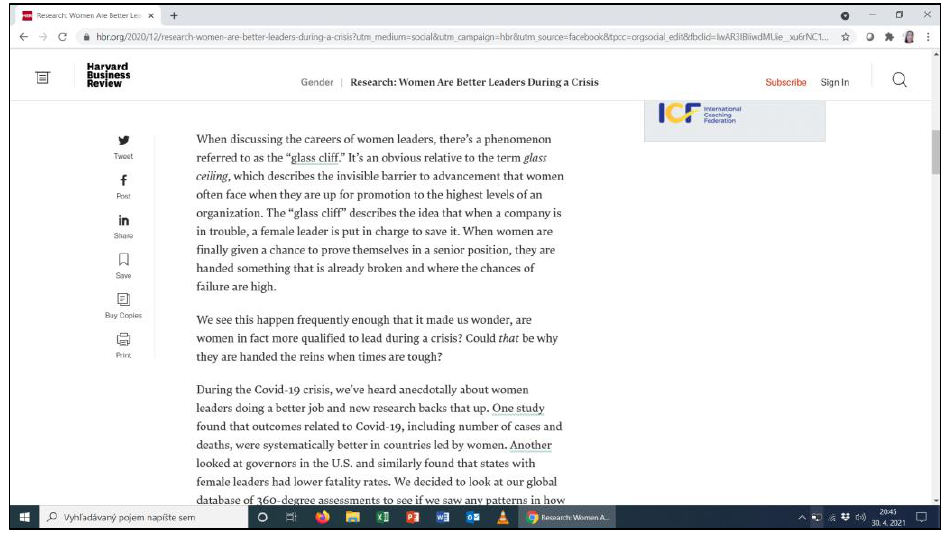
Figure 3. An illustration of the Internet-based articles [25].